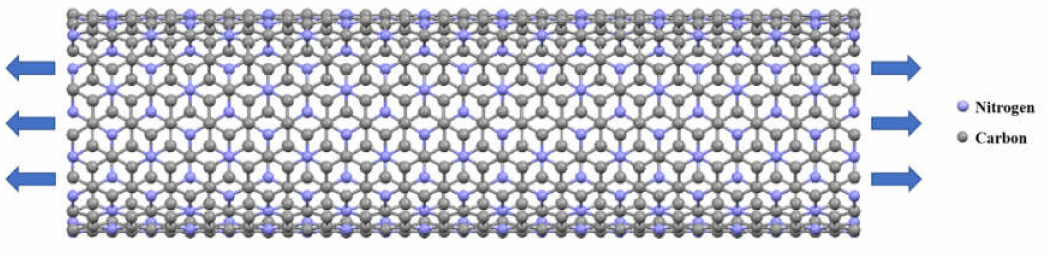
Figure 2. Schematic side view of an armchair SWC 3 NNT under uniaxial tensile